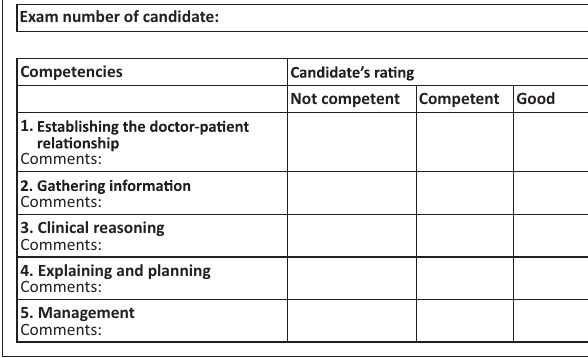
FIGURE 2: Marking template for consultation